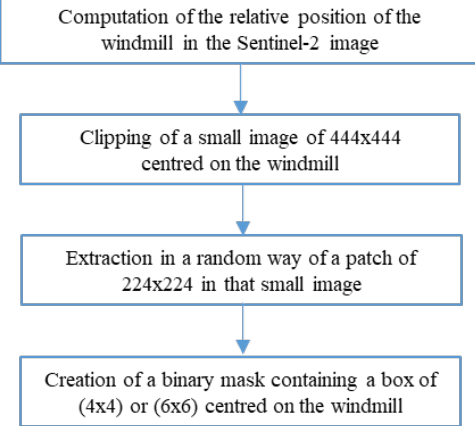
Figure 8 . Image data set creation